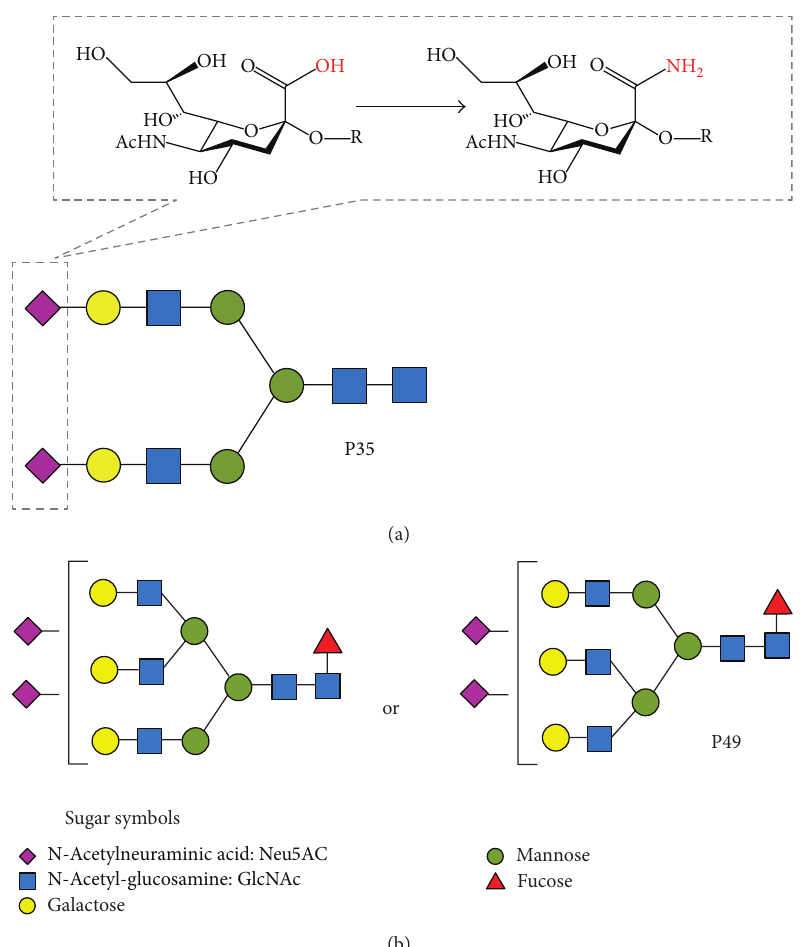
Figure 2: N -Glycan symbols of internal standard and significant N -glycans selected by logistic regression analysis. O -Benzyl hydroxylamine hydrochloride (BOA)-labeled amidated sialic acids (A2 amide), which do not exist in nature (peak number 35), were used as the internal standard (a). Putative structures of significant N -glycans selected using Cox regression analysis are presented. Peak number 49 (P49) was selected for overall survival